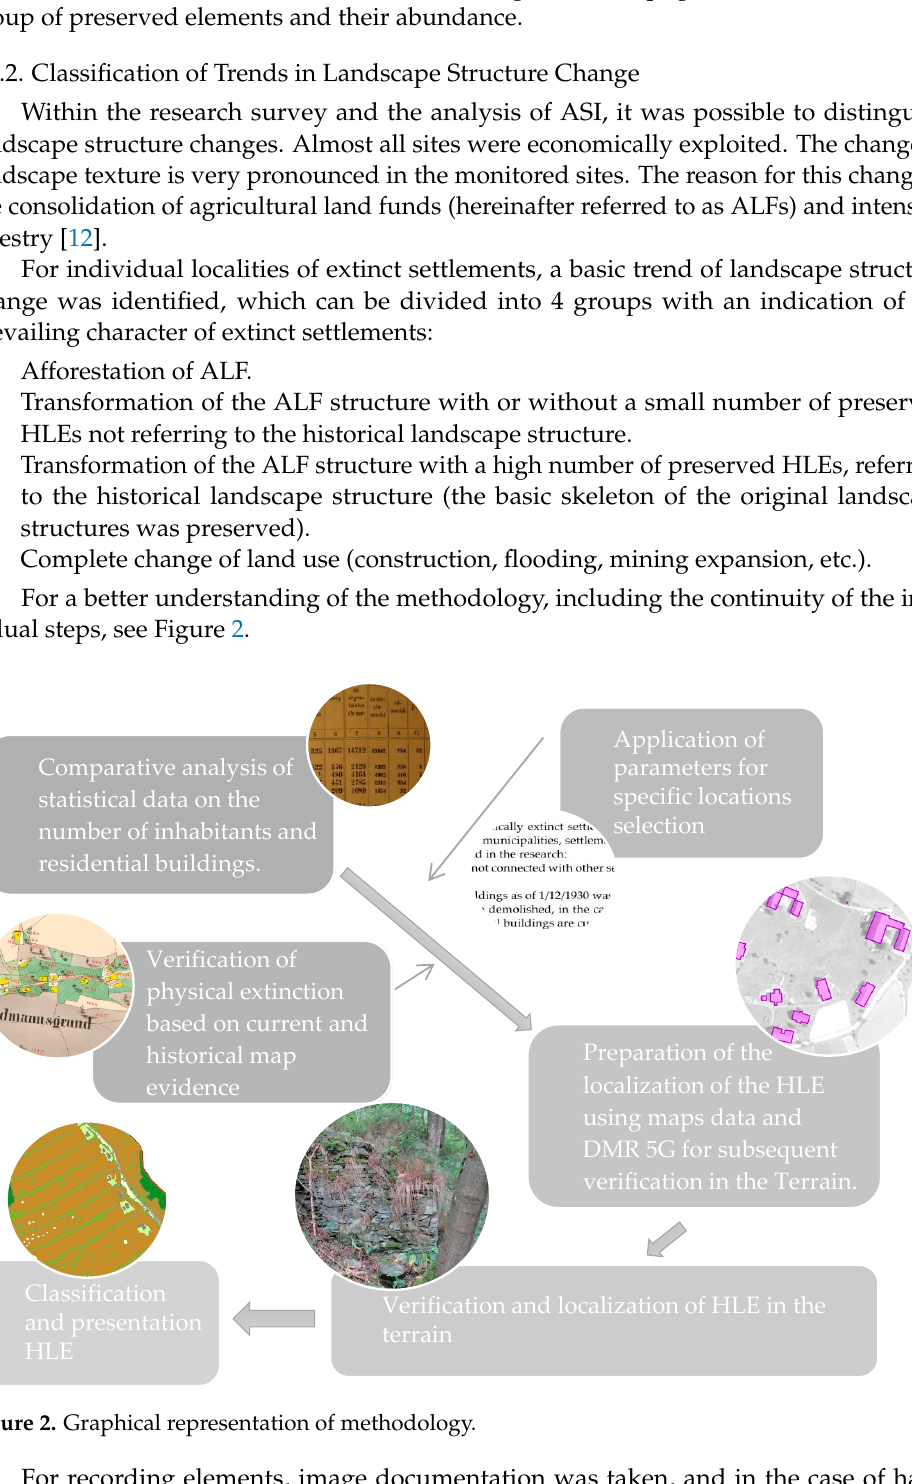
( b ) Figure 3. Chapel St. Anne, Hutov (Hutdörfel), district Bruntál: ( a ) 3D model based on historical documents and ( b ) status as of 2021.